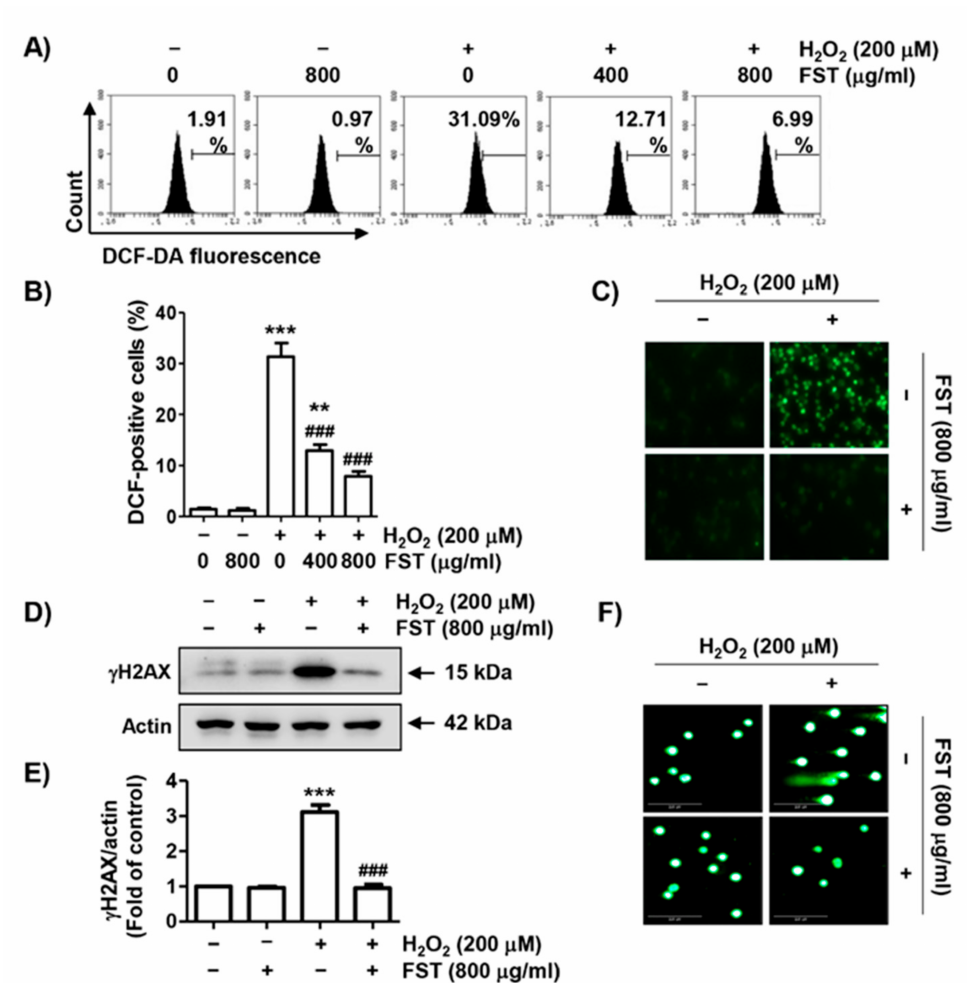
Figure 2. The protective effect of FST on reactive oxygen species (ROS) generation and DNA damage in H 2 O 2 -stimulated MC3T3-E1 cells. Cells were pre-treated with or without FST for 1 h and exposed to H 2 O 2 for 1 h ( A – C ) or 24 h ( D , E ). ( A – C ) Fluorescence intensities of 2 (cid:48) 7 (cid:48) -dichlorodihydrofluorescein diacetate (DCF-DA) were determined by flow cytometry ( A , B ) or fluorescence microscopy ( C